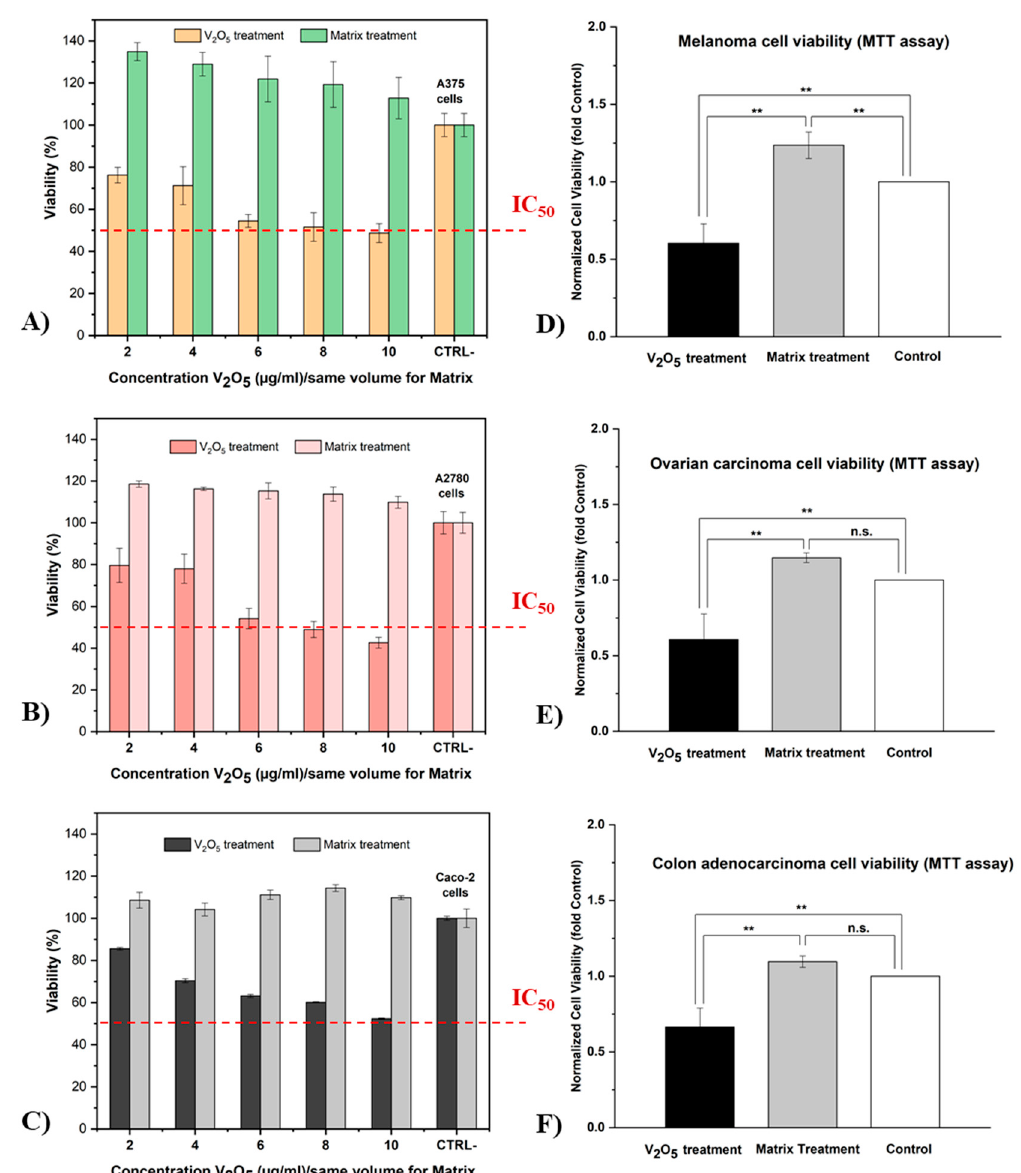
Figure 8. Percentage of viability of three different tumor cell lines ( A , A375; B , A2780; and C , Caco-2) after 24 h incubation with glass extracts V7 and M in different concentrations ( n = 5; error bars represent min–max values) andsignificant differences between the two treatments and the control ( D , E ) and within treatments ( F ) (mean ± SD, ** p < 0.01, n.s. = non-significant).